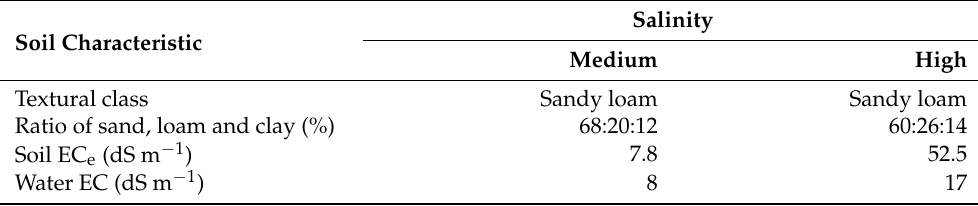
Table 1. Initial soil texture and soil and water salinity in sites of medium and high salinity in Laayoune-Morocco during April